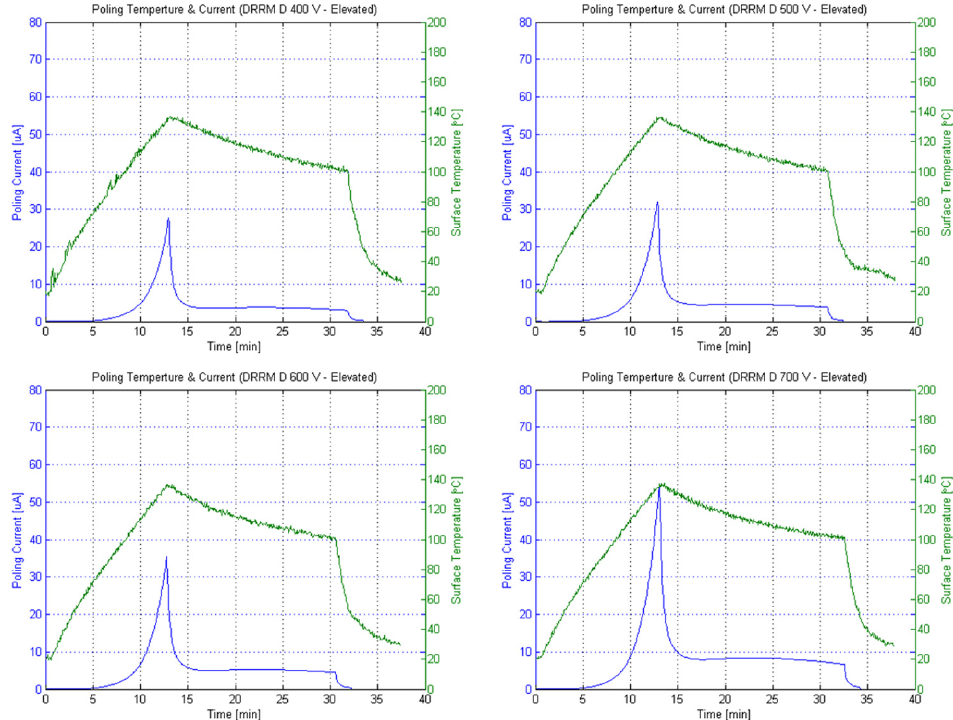
Figure 3. Poling temperature (green) and current (blue) for a waveguide stack poled at 400 V, 500 V, 600 V, and 700 V.